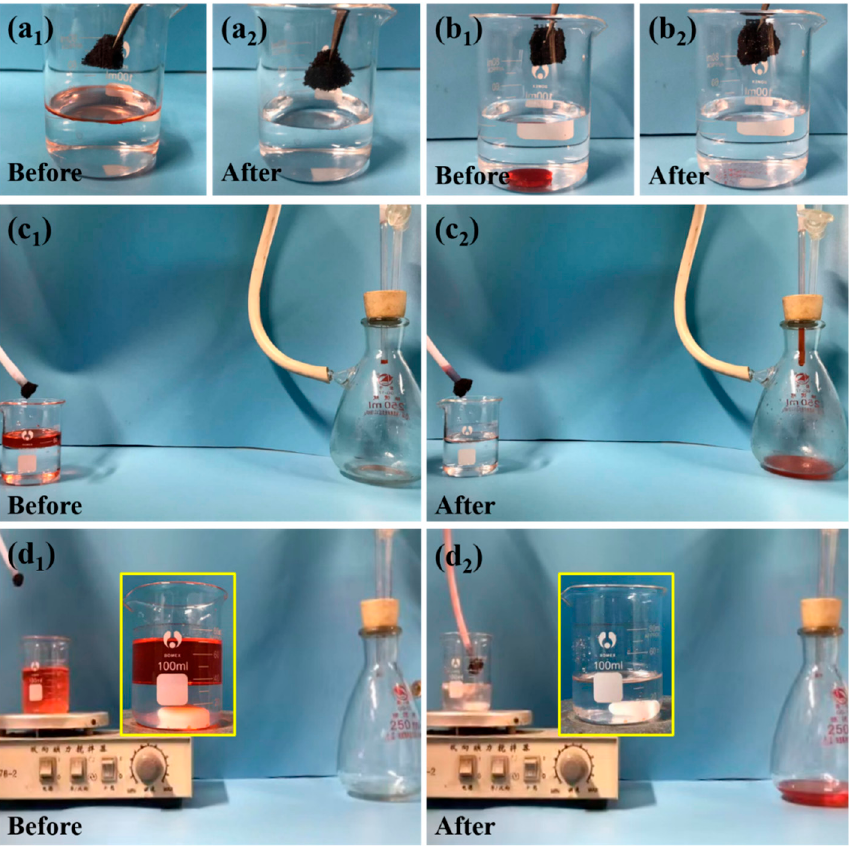
Figure 5. The use of CNT-PDMS sponge for batch absorption ( a 1 , a 2 , b 1 , b 2 ) of cyclohexane ( a 1 , a 2 ) and tetrachloromethane ( b 1 , b 2 ) from immiscible oil–water mixtures, and continuous